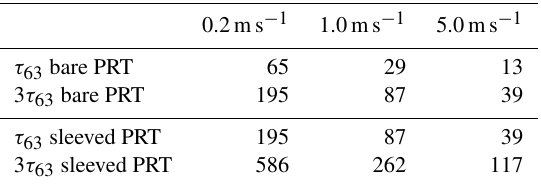
Table 2. Comparison of calculated response times (s) for a nominal “bare” PRT of 3mm diameter in varying airflow, and for the same sensor sleeved in a (dry) wick – here representing two identical sensors where the response time differences are due solely to the presence of the wick around the sensor. Based upon experimental work and empirical relationships described in Burt and de Podesta